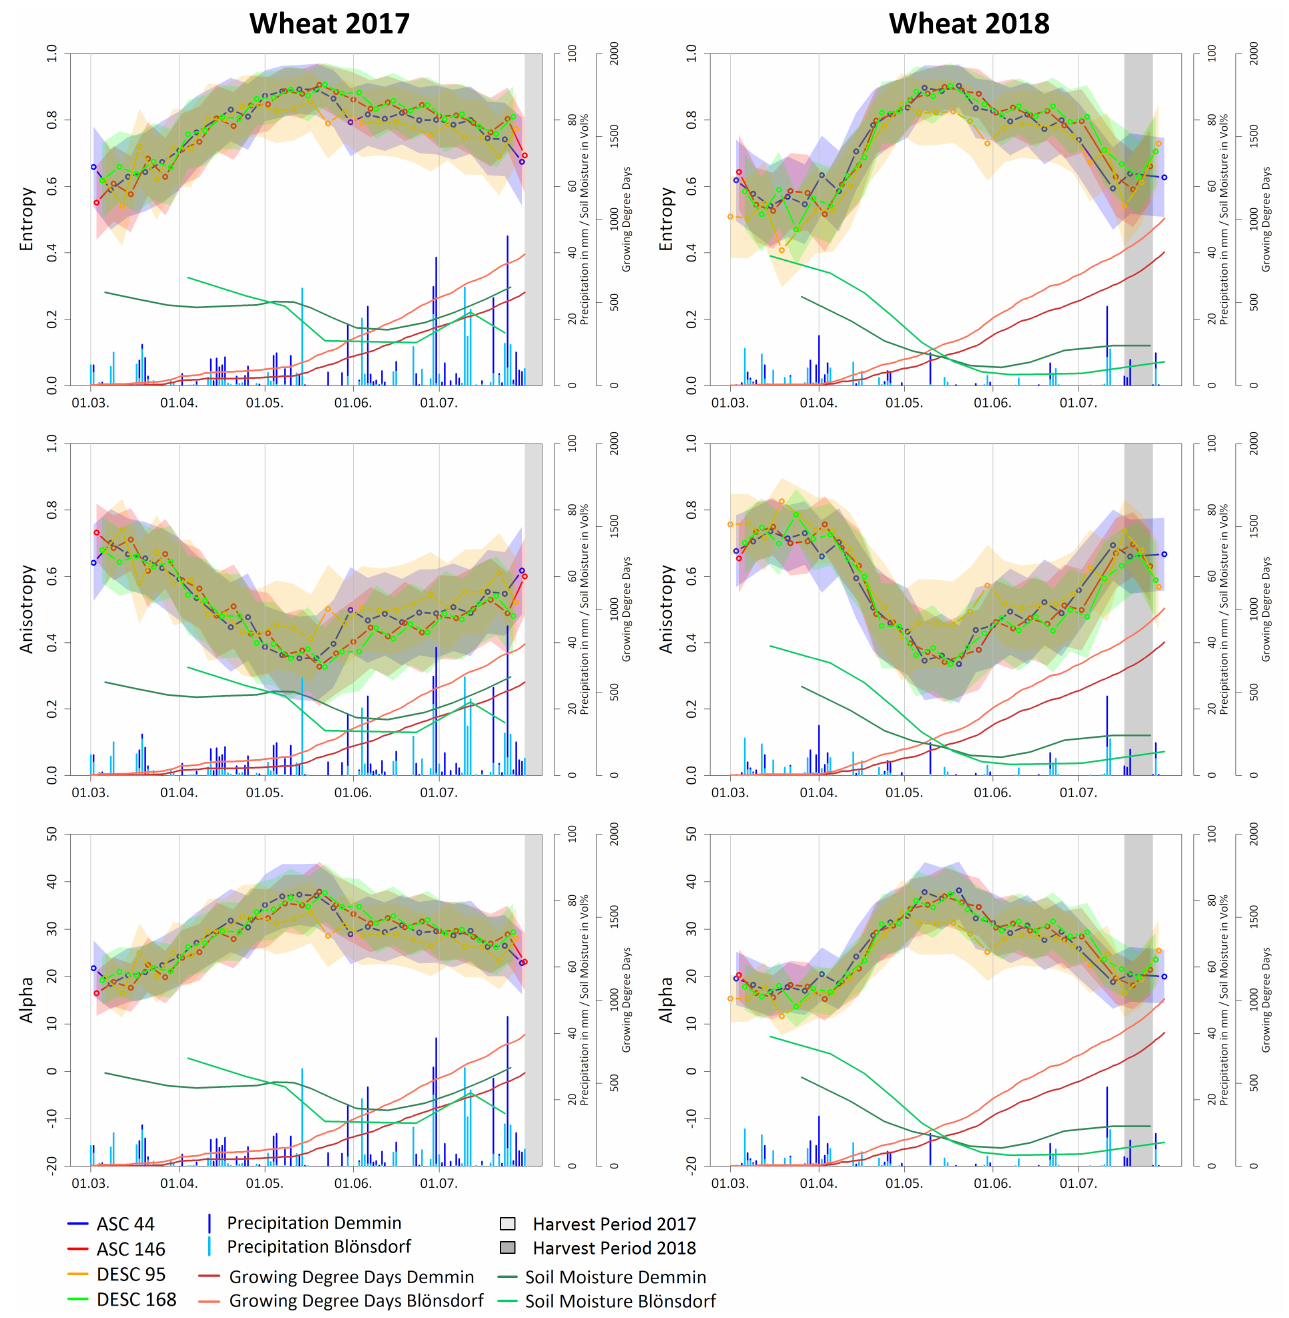
Figure 6. Temporal development of decomposition parameters entropy, anisotropy, and alpha for all wheat fields in 2017 ( left ) and 2018 ( right ): polygons around the lines indicate ± one standard deviation. Blue bars represent the daily precipitation sums, red lines show the cumulative growing degree days, and green lines represent soil moisture at both test